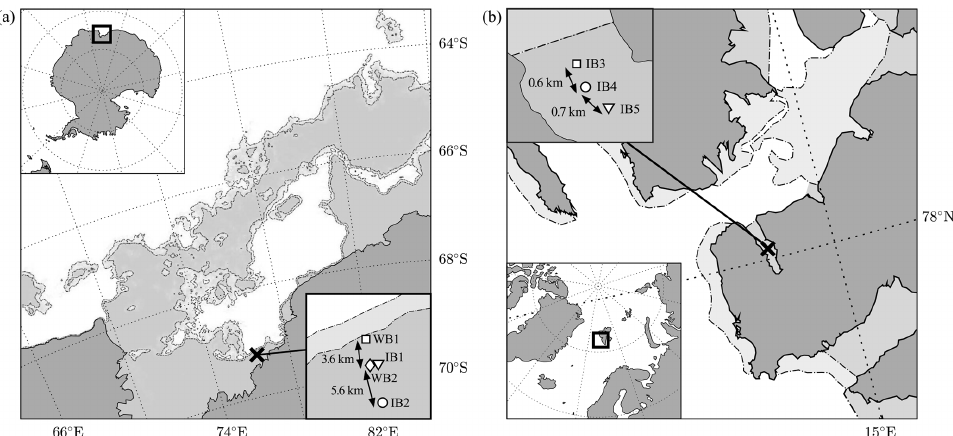
Figure 1. Map of the field experiment sites on (a) Antarctic fast sea ice and (b) fast ice in Svalbard. Deployment sites are indicated by a cross. Continents are shaded dark grey, whereas sea ice concentration is represented by the light grey shades using two contour levels, indicative of (a) sea ice concentration of 25 and 75% derived from AMSR2 for 2 January 2020 (Spreen et al., 2008) for light and dark grey, respectively, and (b) open drift ice and very close drift ice obtained from the Norwegian Meteorological Institute Ice Service for 23 March 2020 for light and dark grey, respectively. Instruments were deployed along a line perpendicular to the unbroken ice edge (see insets) and consisted of wave buoys (WB: Spotter buoys, Sofar Ocean Technologies) and open-source ice motion loggers (referred to as ice buoys, IB; Rabault et al., 2020). Note that in (a) IB1 is shifted laterally for visualization purposes, but in reality it is only 40m apart from